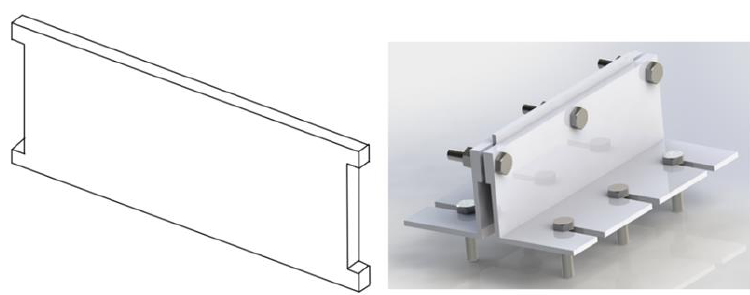
Figure 5. Proposed substrate configuration (plain carbon steel) and respective fixture.